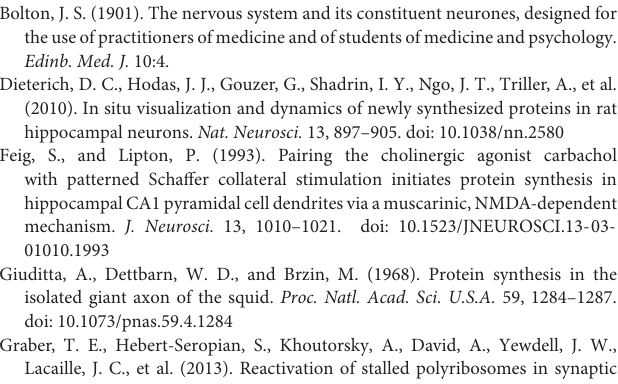
FIGURE S1 | Workflows for image processing with or without applying the default convolution kernel (Laplacian filter). Images show the same cells used as examples for the workflow in Figure 1 . (B) Represents the same step by step processing method described Figure 1B . (B | ) Corresponds to the same workflow as in Figure 1B excluding step 1 which corresponds to the application of the Laplacian filter to enhance the edges. Both workflows converge in graphs comparing both methods (green line, filter application; red line, no filter) in two experimental conditions (condition 1, blue; condition 2, red). Graphs